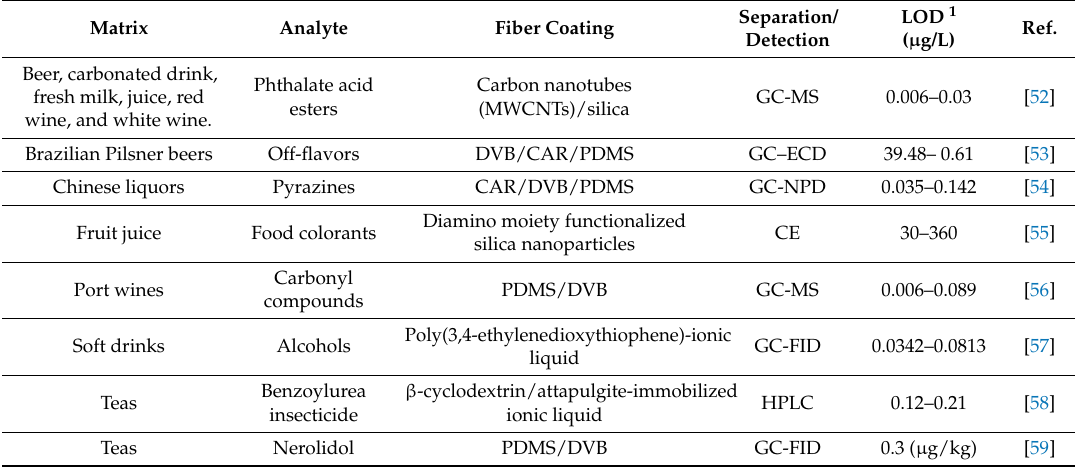
Table 2. Application of SPME as a sample preparation technique in the analysis of beverages.